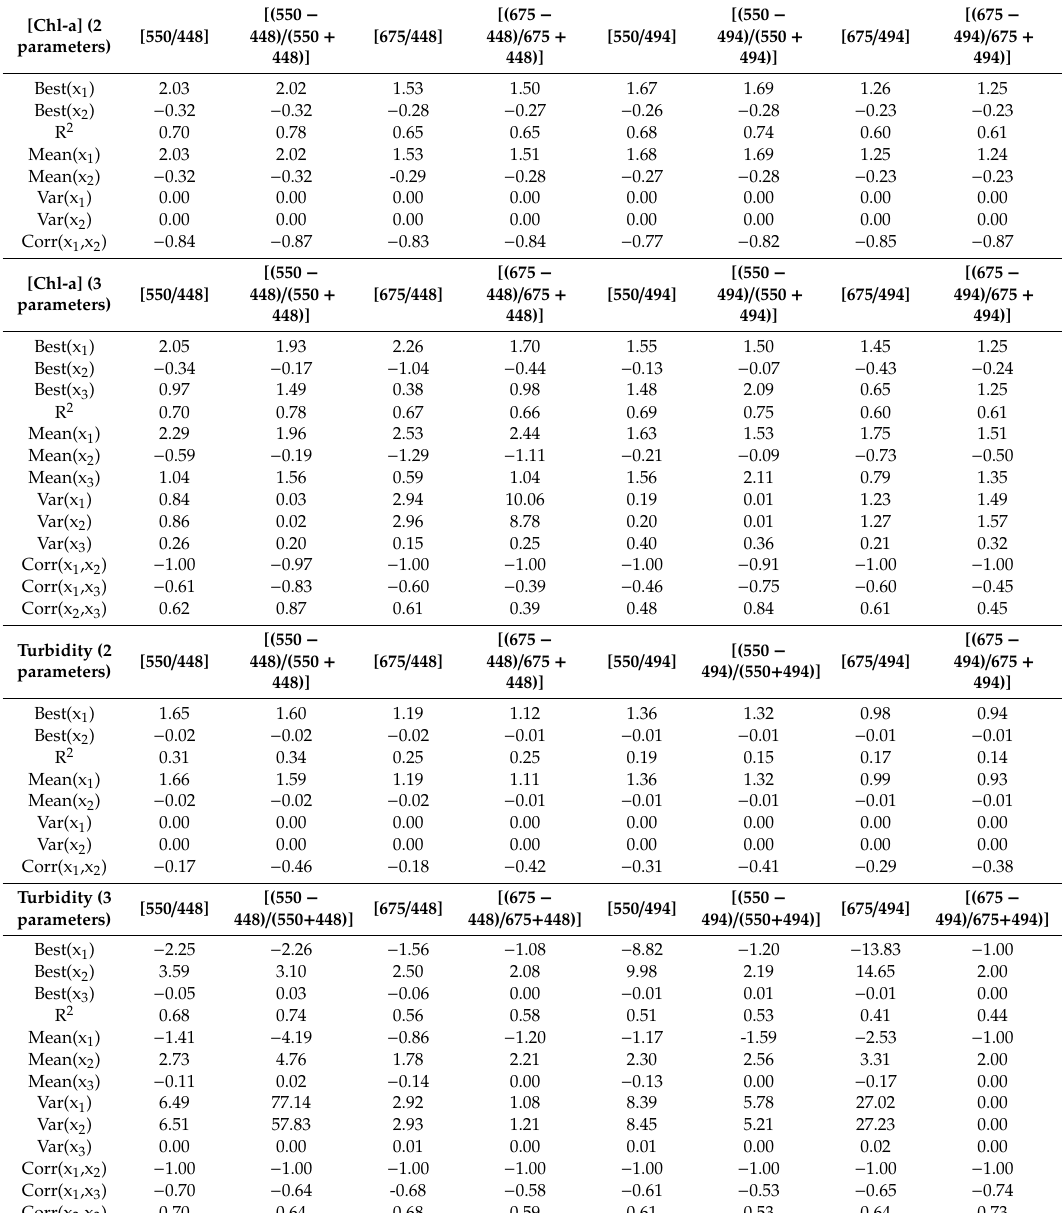
Table 3. Parameter estimates for the calibration models (2 and 3 parameters) applied to the Reflectance ratios and indexes, as functions of concentration of chlorophyll a concentration ( µ g · L − 1 ) and Turbidity (FNU). Between brackets are ratios or indices combining reflectance measured at 4 di ff erent wavelength bands centered on 448, 494, 550 and 675 nm. Mean and covariance were calculated from 200 bootstrap